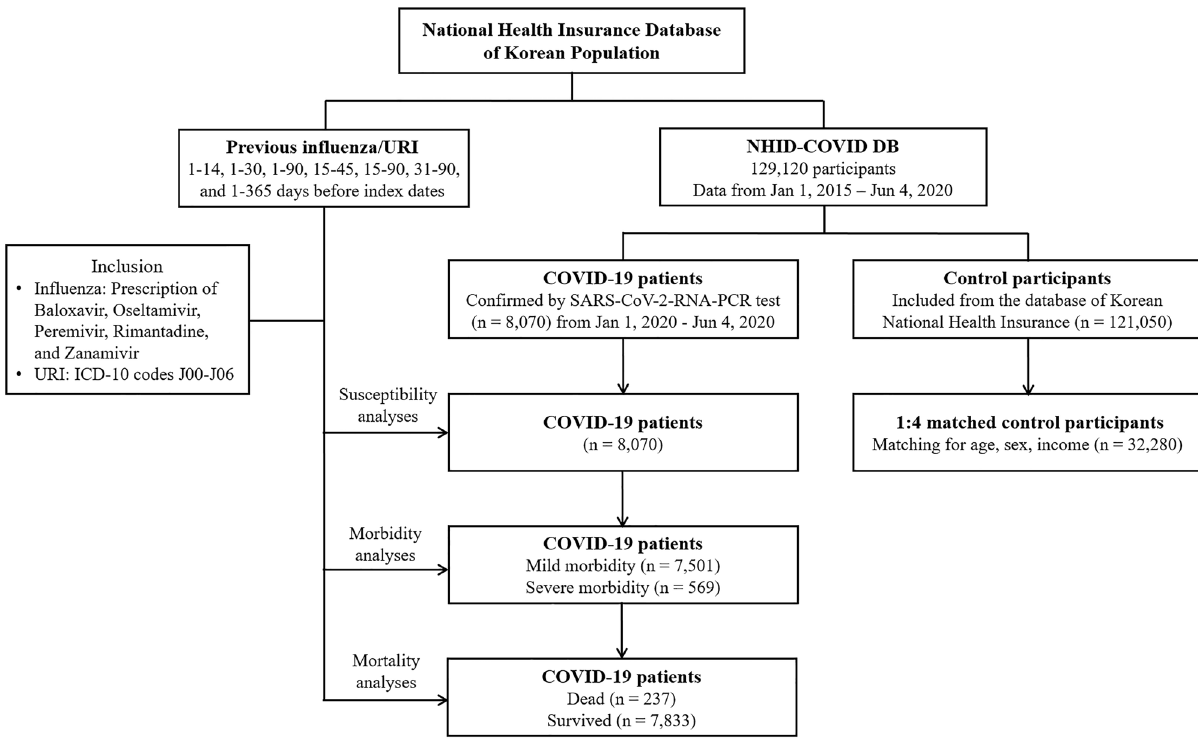
Figure 1. A schematic illustration of the participant selection process that was used in the present study. Of a total of 129,120 participants, 8,070 COVID-19 participants were matched with 32,280 control participants for age, sex, and